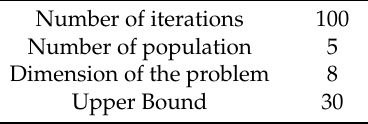
Table 1. Parameter Initialization.